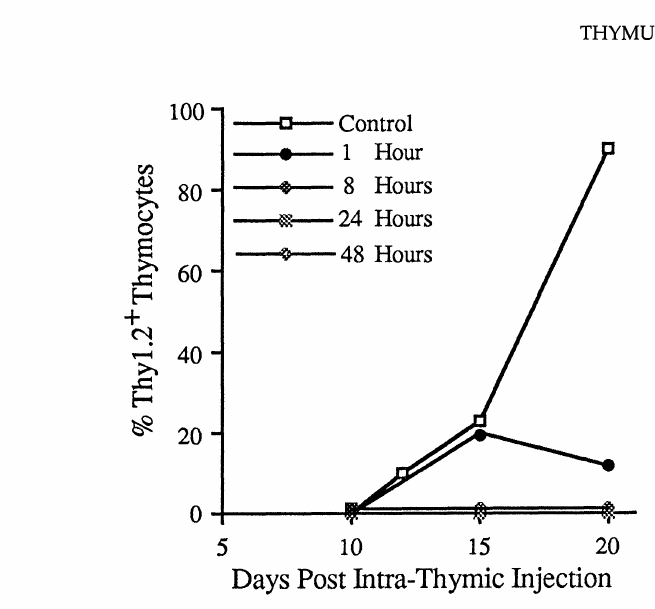
FIGURE 4. Proliferative response of day-12 fetal liver to cytokines and the detection of thymic reconstitution by cytokine grown cells. Day-12 C57BL/ Thyl.2 fetal liver was removed and a single-cell suspension was prepared. Cells were plated in 24-well plates at 5 x 105 viable cells per milliliter. The designated cytokines were all added at 20-30 ng/ml. The medium was replaced 5 days after establishing the cultures, and on day 7, the cultures were harvested and the number of viable cells determined. Each figure plotted represents the mean of 7-10 wells. Sublethally irradiated C57BL/ Thyl.1 adults (6-10 per group) were injected I.T. with 3-5 x 105 viable cells from each culture condition. The per- cent of donor-derived Thyl.2 cells was determined on day 21. The groups with mice showing repopula- tion are marked with an